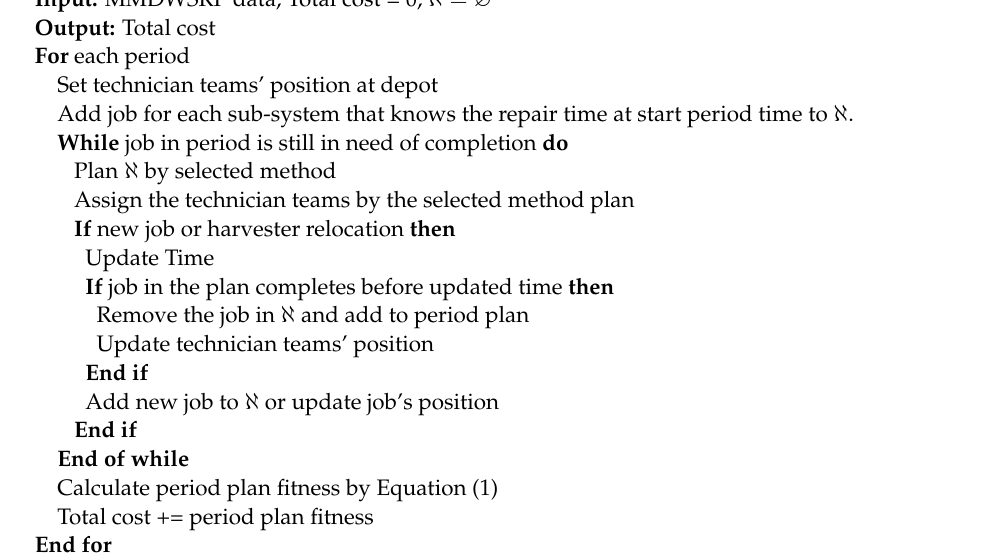
Algorithm 1. Re-schedule for multi-visit and multi-period dynamic workforce scheduling and routing problem